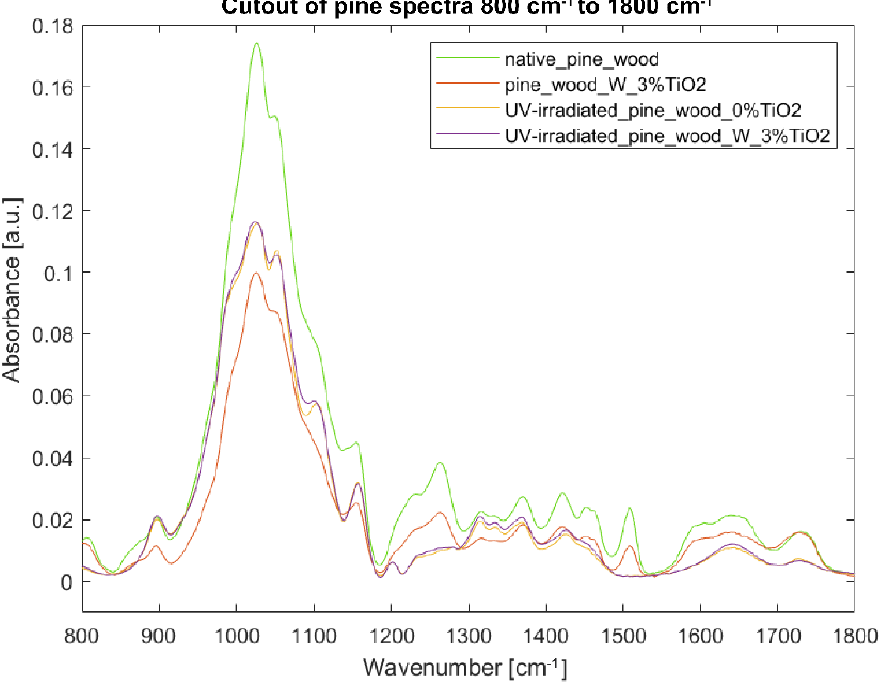
Figure 10. FTIR-ATR spectra of pine wood samples in the fingerprint region 800–1800 cm − 1 : (green) reference sample of native pine wood, (red) pine wood with 3% TiO 2 coating with water as binder, (yellow) UV-irradiated pine wood without TiO 2 coating, and (purple) UV-irradiated pine wood with 3% TiO 2 coating with water as binder.